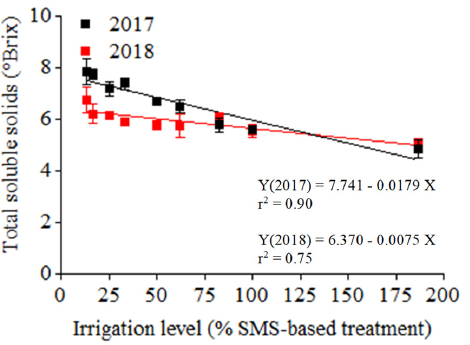
Figure 7. Effect of irrigation level on total soluble solids of tomato fruits in 2017 and 2018. Data are means of three replicates ± standard errors. SMS = soil moisture sensor. Linear regression models for each year are displayed in the fi gure.